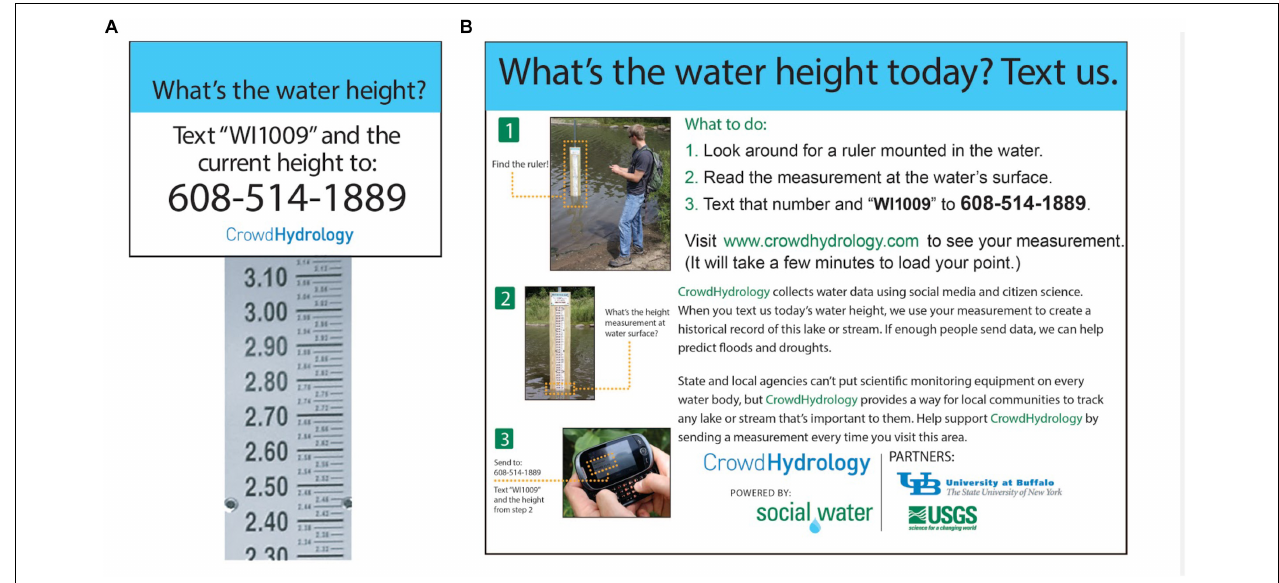
FIGURE 1 | CrowdHydrology informational signage in (A) stream and (B) on shore asking citizen scientists to send in observations of water levels.